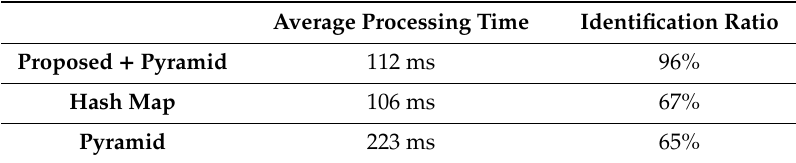
Table 4. The experimental result of generated plume